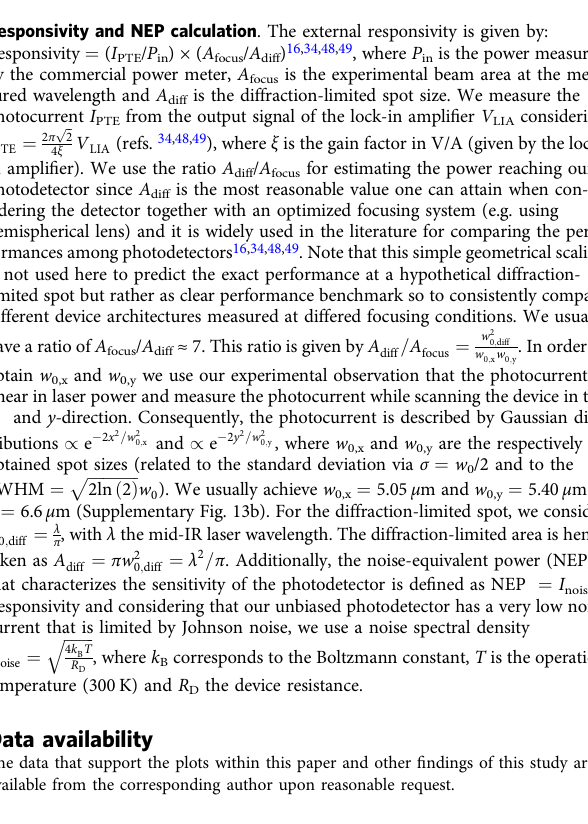
Fig. 5 Photodetection speed and power dependence. a Time-resolved photodetection traces at λ = 6.6 μ m, compared with a MCT detector (both plotted in black dots and blue line respectively) and the respective QCL voltage signal (brown line). The QCL pulse width corresponds to 496 ns. The photovoltage fi ts are shown in red lines. We obtain rise times of 9 ± 3 ns and 17 ± 3 ns for the MCT and our device respectively. b Photocurrent as a function of laser power ( P diff = P in × A diff / A focus , see Methods) for different wavelengths on a log-log scale. Circles correspond to the data points, while the dashed lines represent the fi ts according to I / P γ . Among all cases, γ ranges from 0.92 – 0.98. We observe linear PTE diff photoresponse over three orders of magnitude of power (limited by the power meter sensitivity range for P in calibration). These results suggest that we are operating in the weak heating regime ( T e − T l << T l ) 16,23 , as in the strong heating regime ( T e − T l >> T l ), a sublinear behavior is expected ( γ = 0.5) 16,23 . Here T e is the electronic temperature and T l is the graphene lattice temperature, which the latter is in thermal equilibrium with the bow-tie antenna interactions with gates and metal electrodes, resulting in the non- optimal performance as evident from Fig. 4. By performing 2-terminal con fi g- uration electrical measurements as a function of the gate voltages (varying V L and V R both at the same potential), we attain 12,000 cm 2 V − 1 s − 1 as a lower bound of the estimated mobility (Supplementary Figs. 15, 16 and Supplementary Note 4).